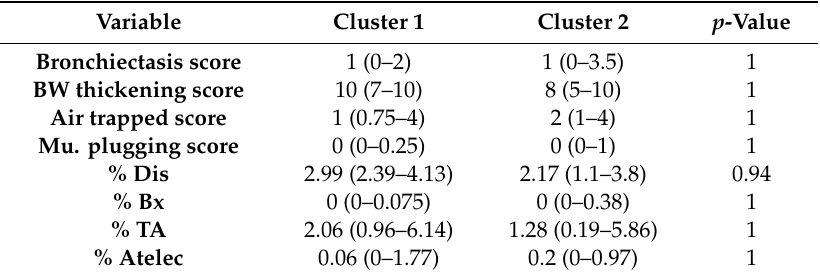
Table 2. Quantification of structural lung disease at the time of the collection of the BALF samples from patients classified in cluster 1 or cluster 2. Lung disease was scored using either volumetric CT scans or the recently reported PRAGMA-CF methodology [40]. Calculated probabilities for rejecting the null hypothesis of samples coming from the same population in the context of the Mann-Whitney test were corrected for multiple comparisons using Bonferroni approach. BW, bronchial wall; Mu, Mucus; %Dis, volume proportion of the lung with airway disease [40]; % Bx, volume proportion of the lung with bronchiectasis [40]; %TA, volume proportion of the lung with trapped air [40], % Atelec, volume proportion of the lung with atelectasis